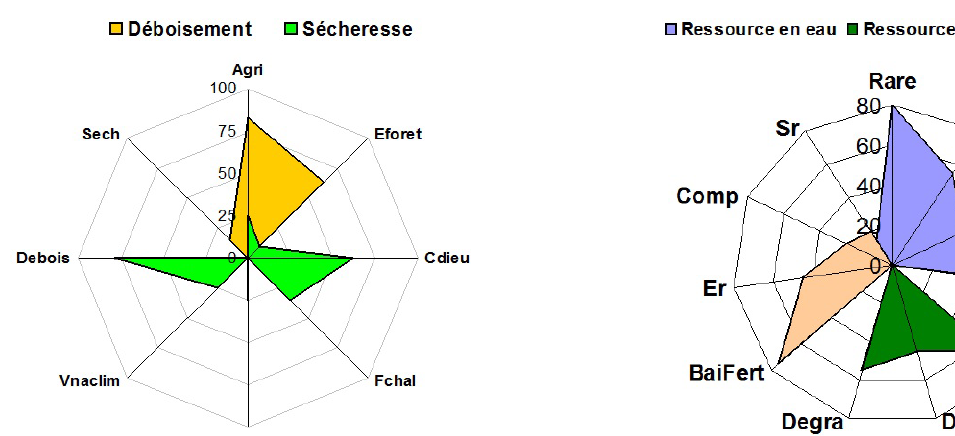
Figure 3. Effets du déboisement et de la sécheresse selon les perceptions. Légende : Rare = raréfaction; Disp = disparition; Tari = tarissement précoce; Comb = Comblement; Rare_esp = raréfaction d’espèces; Disp_esp = disparition d’es- pèces; Degra = dégradation d’écosystèmes; BaiFert = baisse de fertilité; Er = Erosion; Comp = Compactage; Sr = sans